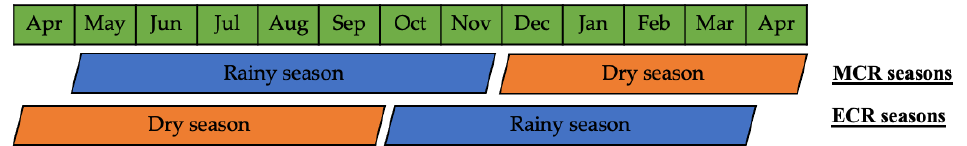
Figure 4. Differences in the annual seasons of the monsoon climate region (MCR) and equatorial climate region (ECR).